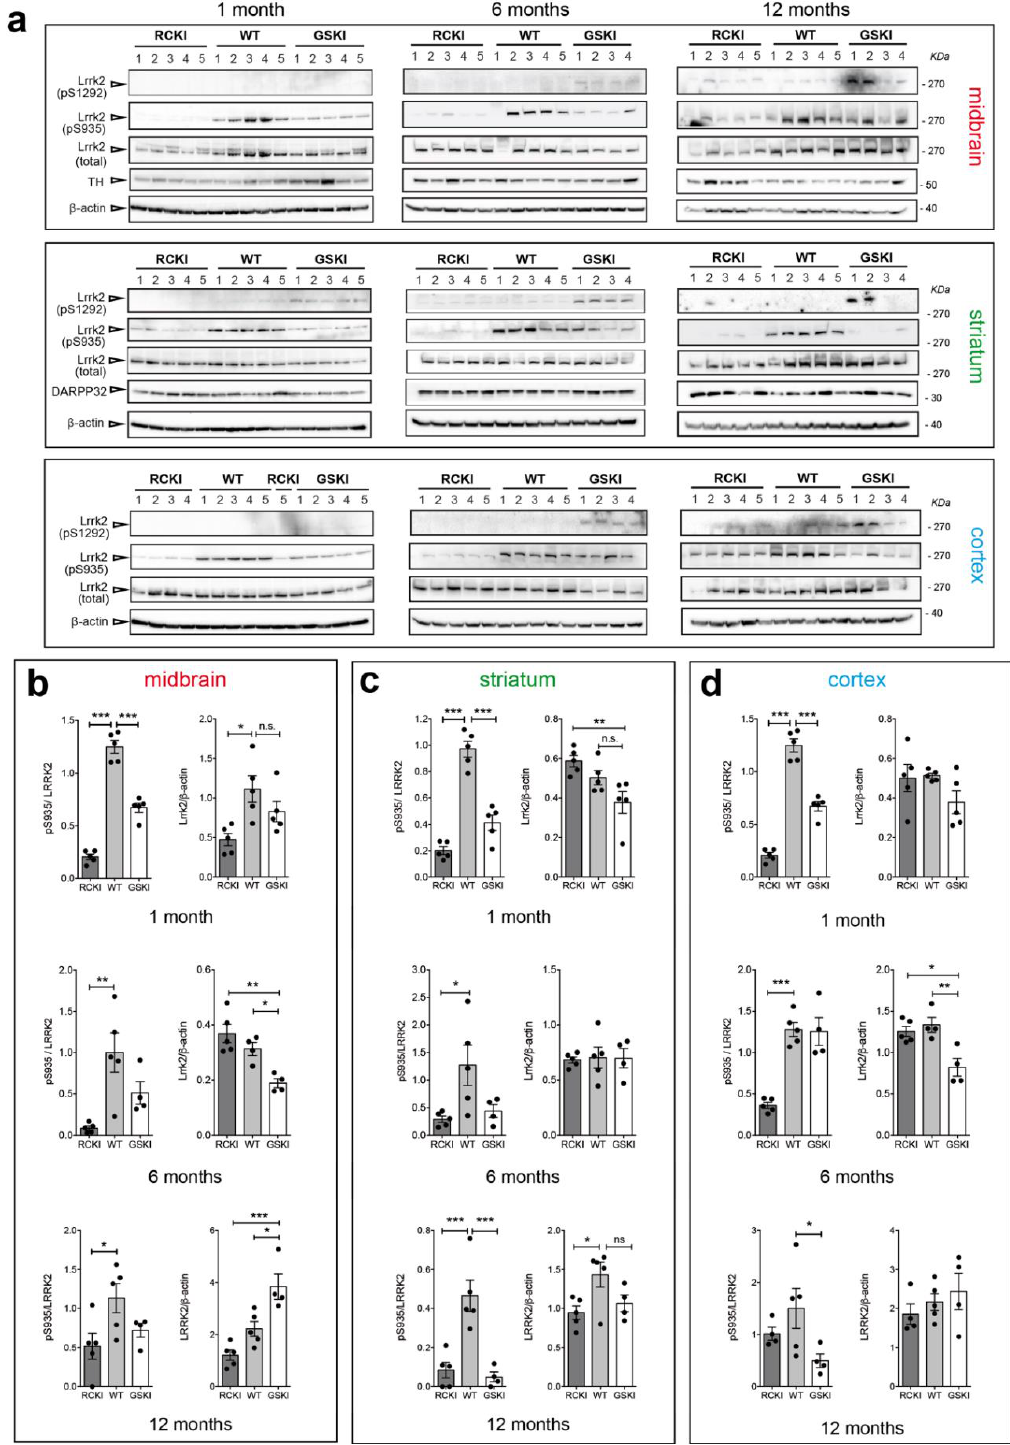
Figure 2. Age-related changes in Ser935 and Ser1292 phosphorylation levels in G2019S and R1441C knockin brain areas. ( a ) Representative western blots of R1441C knockin (RCKI), wild-type (WT) and G2019S knockin (GSKI) lysates from midbrain, striatum, and cortex of 1, 6, and 12-month-old animals ( b-d ). Quantifications of Ser935 phosphorylation (phospho/total LRRK2) and total Lrrk2 levels (Lrrk2/ β -actin) in midbrain ( b ), striatum ( c ), and cortex ( d ) at 1, 6, and 12-month-old mice. Each dot in the bar graph represents one animal. Data are shown as mean ± SEM; One-way ANOVA with Dunnett post-hoc test (ns: not significant; * p < 0.05; ** p < 0.01; *** p <